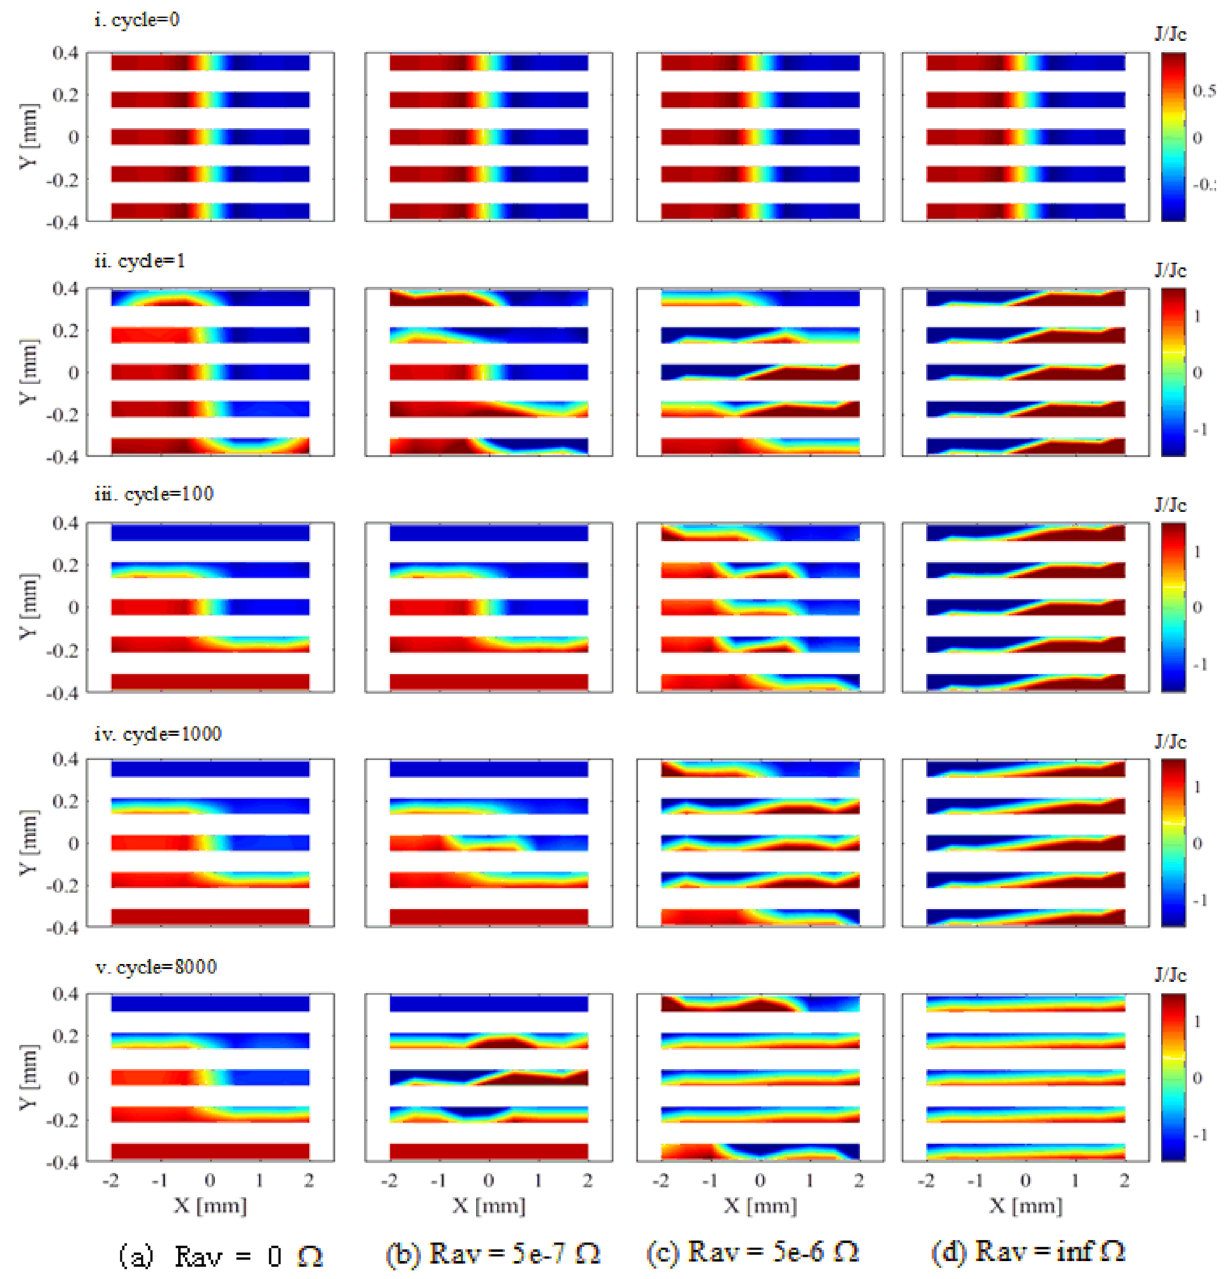
Figure 5. Current density maps of the stack suffering from 200 mT cross-field at frequency 2400 Hz. Five typical cycles are chosen, they are cycle = 0, 1, 100, 1000, and 8000. The thickness of the tapes are scaled 50 times to draw the pictures. ( a ) is the fully coupled stack which is the same as zero average end resistance, R av = 0 (cid:31) . ( b ) and ( c ) are partially coupled stacks with average end resistance of 5 × 10 − 7 and 5 × 10 − 6 (cid:31) , respectively, and ( d ) is the uncoupled stack, where R av = ∞ (cid:31)